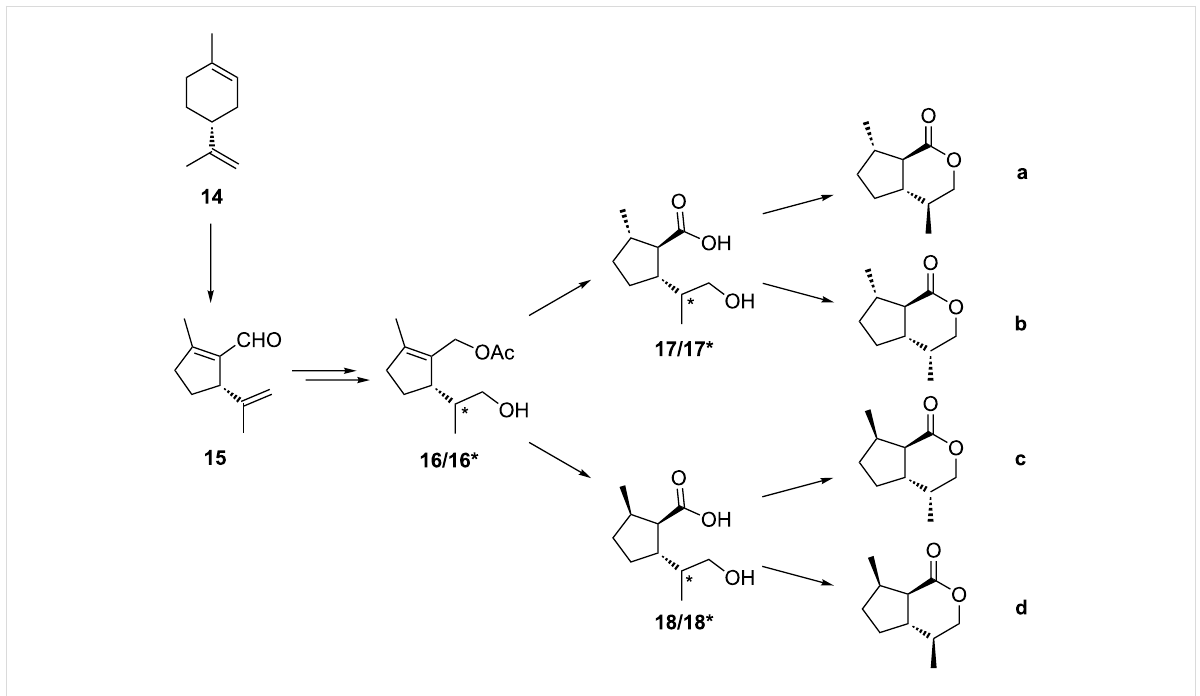
Figure 5: Route to stereochemically pure trans -fused dihydronepetalactones a – d from ( R